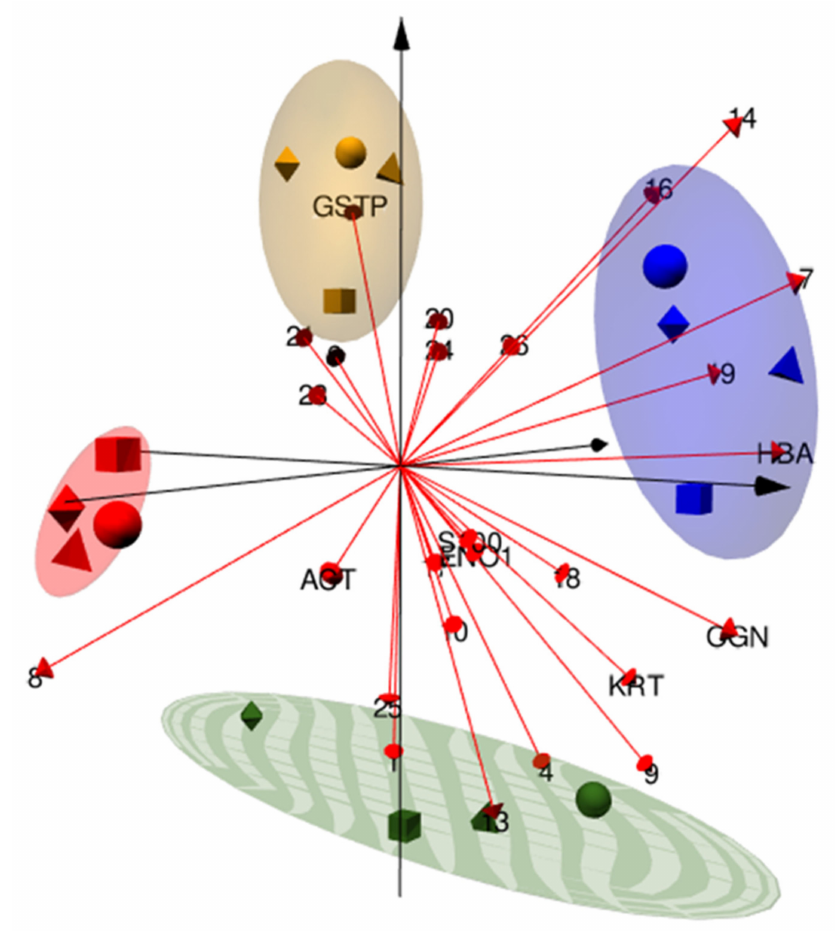
Figure 5. Differentially abundant spot PCA. 3D Principal Component analysis (PCA) bi-plots performed on the significant differentially abundant spots; 66.2% of variation is explained by the first three PCs (35.8%, 19.9%, and 10.5%, respectively). While the same geometrical form al- ways indicates the same animal (square = animal #1; circle = animal #2; triangle = animal #3; rhombus = animal #4), different colors of the geometrical forms specify the different treatments: chrysene = red; MEHP = green; PBDE-47 = yellow; and DMSO = blue. Variables are illustrated as red arrows, and corresponding protein abbreviations (i.e. protein spots identified by MS) or spot numbers (i.e. not identified protein spots) are reported on their top. The 0.75 of confidence intervals per each cohort is shown by